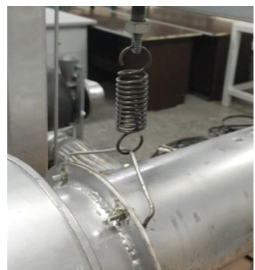
Figure 3. Experimental constraint spring.